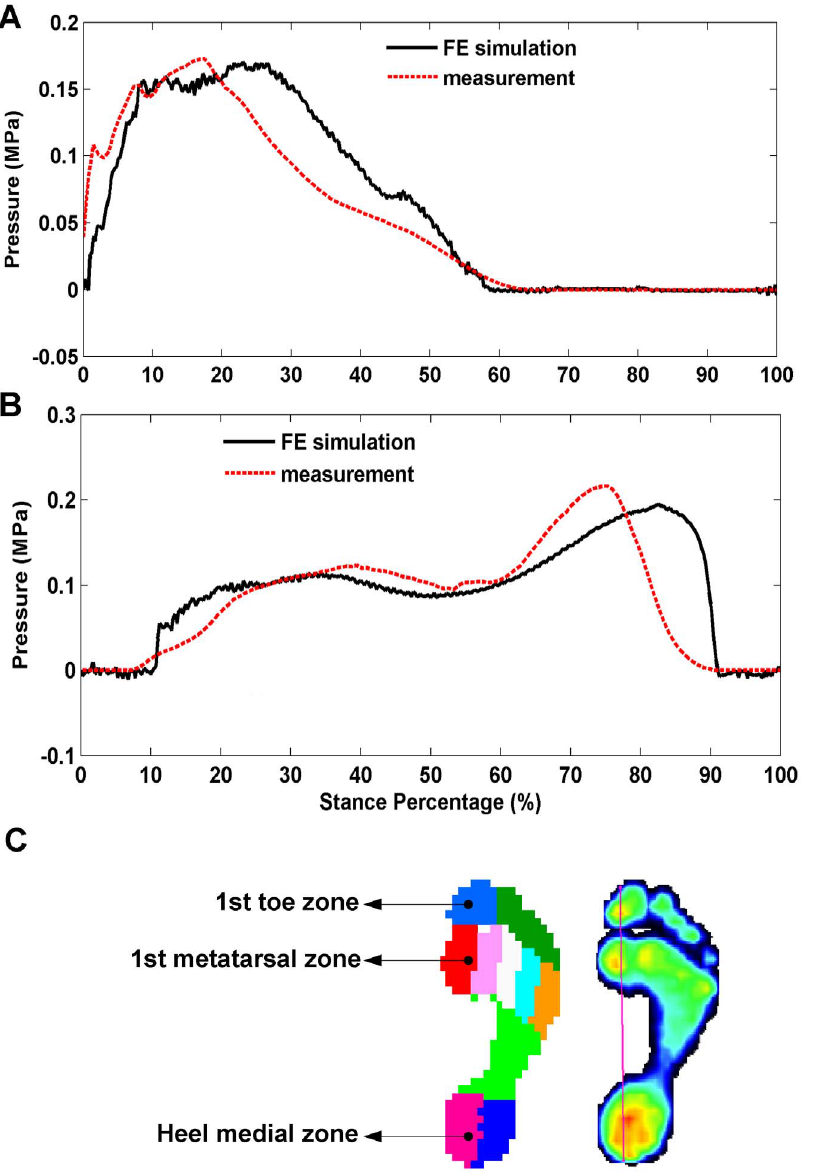
Figure 5. The calculated plantar pressure changes over the whole stance phase compared to the measurement data. (A) in heel medial region. (B) in the first metatarsal head region. The foot-ground contact area was divided into ten zones in the RSscan pressure plate system (C), so the zonal pressures could be directly calculated.